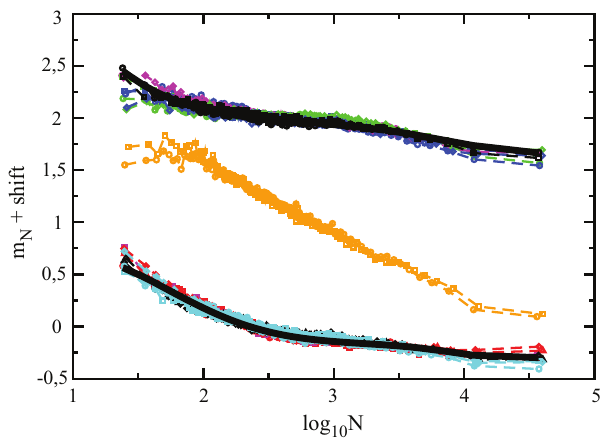
Figure 5. Shifted S t T N ~ m N as a function of N for French elections. Three families of elections clearly appear. a) Top curves: ‘‘important’’ national elections (Presidential, Referendums, Parliament); b) Bottom curves: less important national elections (European, Re´gionales ); and c) Middle curves: Municipales (see text). Each point comes from the average over around 200 communes of size & N .